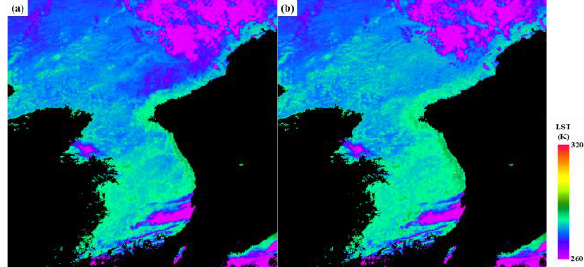
Figure 2. Before and after correction of height effect in MWIR image